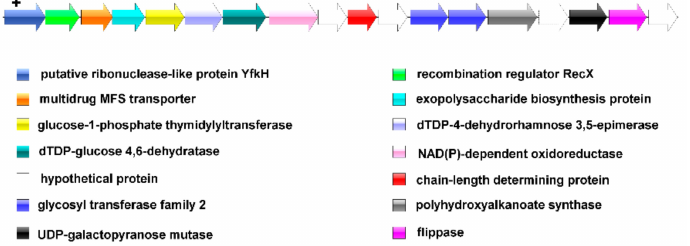
Figure 4. Prediction of exopolysaccharide (EPS) synthesis gene cluster in L.